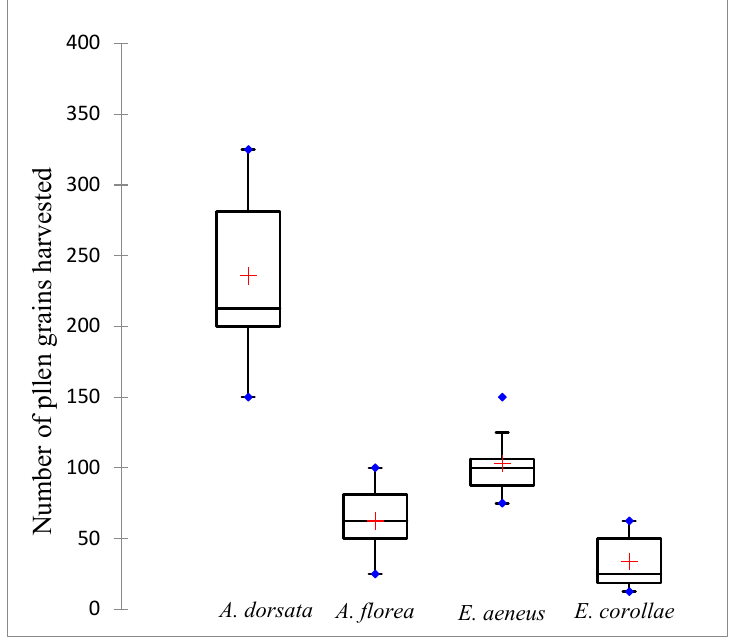
Figure 1. Box ‐ and ‐ whisker plot of single ‐ visit pollen harvest of insect pollinators. Figure 1. Box-and-whisker plot of single-visit pollen harvest of insect pollinators. Table 2. Foraging behavior of two honey bee and two syrphid fly species in terms of stay time and visitation rate in a strawberry field in Multan, Pakistan.